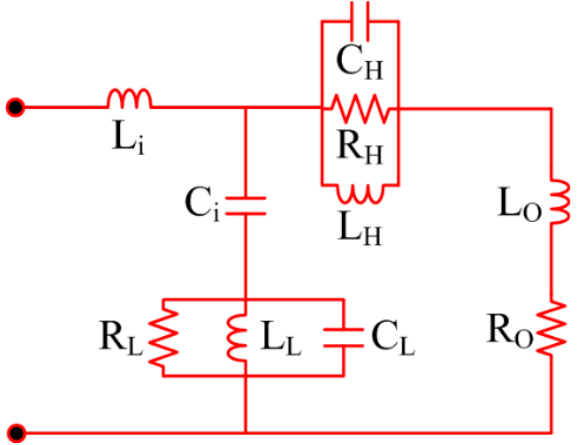
Figure 5. Equivalent circuit model of proposed dual-band antenna (C i = 2.8 pF; L i = 6 nH; R L = 760 Ω ; L L = 2; C L = 1.1 pF; C H = 3 pF; R H = 1500 Ω ; L H =4.3 nH; L O = 2 nH; R O = 15 Ω ).